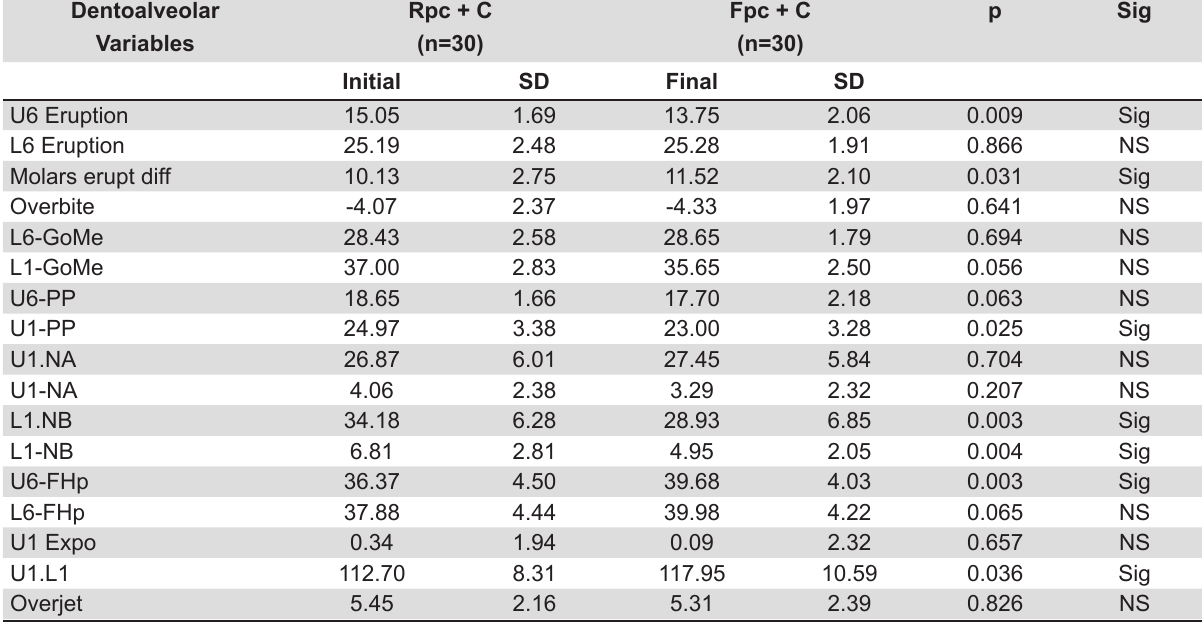
p<0.05 - Sig: Significant - NS: Not significant